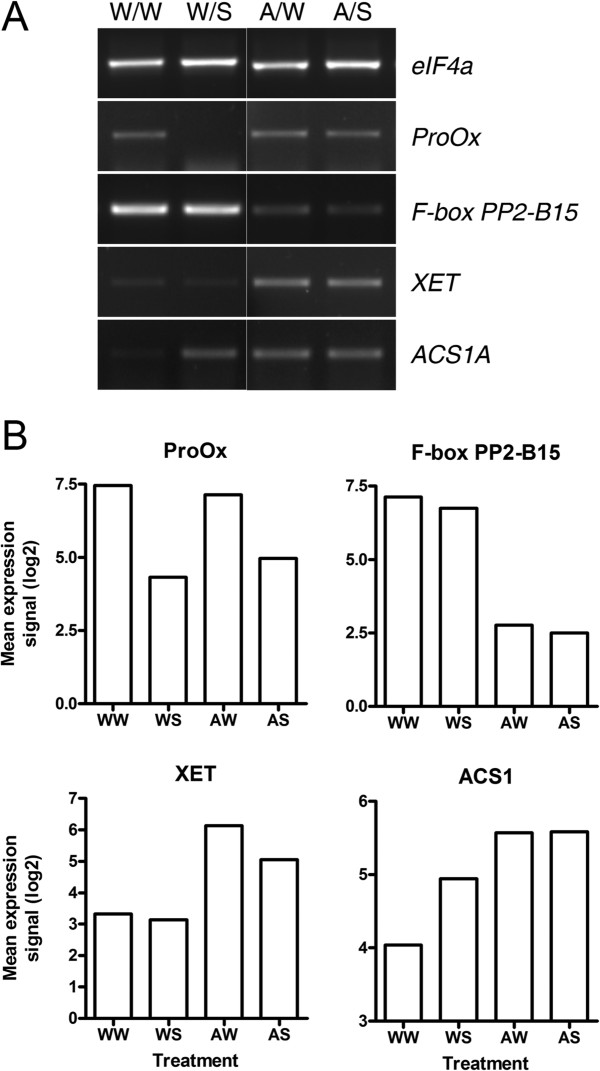
RT-PCR assays confirm expression of differentially-regulated genes. (A) RT-PCR products generated using cDNA templates from RNA extracted from one of the microarray replicate experiments. ProOx; proline oxidase (Unigene Les.1610), F-box PP2-B15 (Unigene Les.23296), XET; xyloglycan endo-transglycosylase (Unigene Les.429), ACS1A; 1-aminocyclopropane-1-carboxylate synthase 1A (Unigene Les.1841). eIF4a; eukaryotic translation initiation factor 4a (Unigene Les.5856), is included as an internal loading control. (B) Plots of mean Affymetrix log2 expression signals from the three replicate microarray experiments for the corresponding genes shown in (A). Notation designates Pre-treatment/Treatment, where W = water, A = Alethea, S = salt.